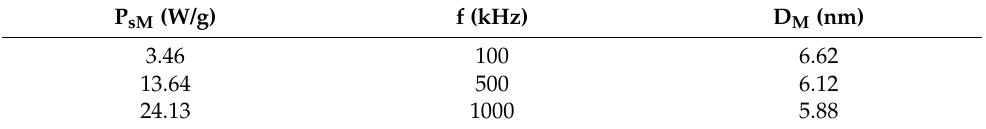
Table 2. The values of maximum specific loss power (P sM ) and the corresponding diameter of and ε = 0.15.